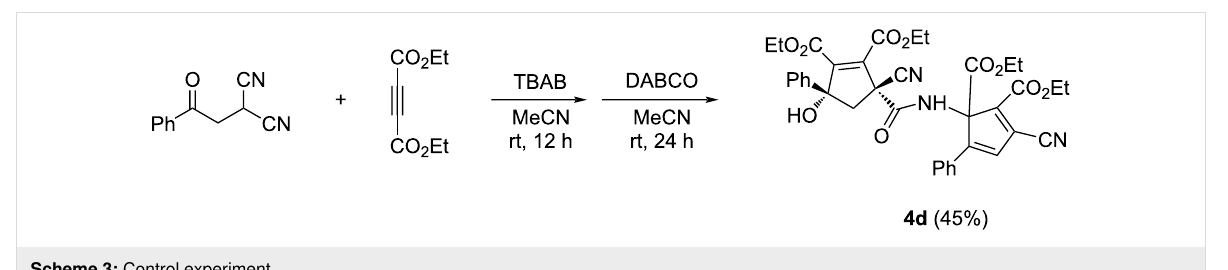
Scheme 3: Control